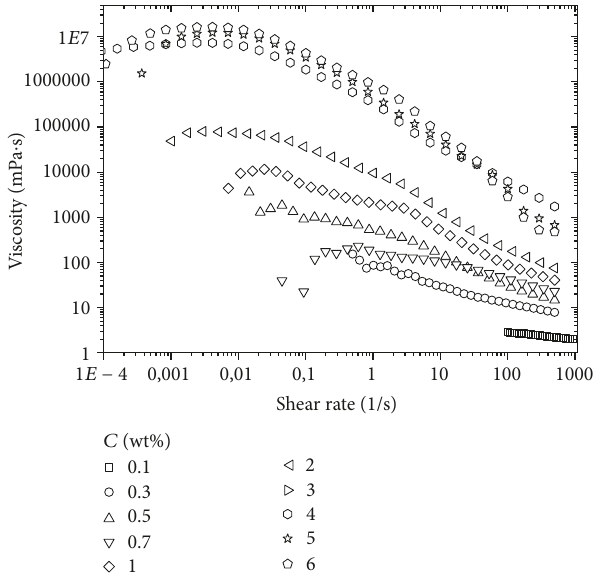
Figure 11: Variation of viscosity in terms of the shear rate for the aqueous solutions for combined copolymers